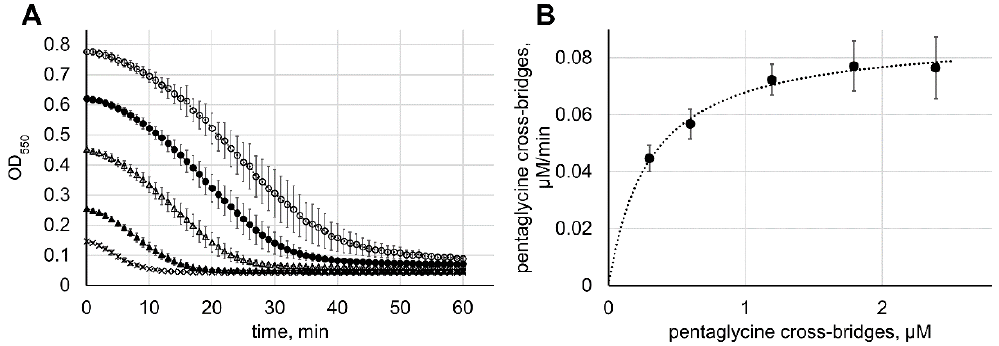
Figure 4. Derivation of apparent catalytic parameters of lysostaphin on pentaglycine incorporated into the cell wall. ( A ) Staphylococcal cells at different initial densities (open circles—8.0 McFarland, filled circles—6.0 McFarland, open triangles—4.0 McFarland, filled triangles—2.0 McFarland, crosses—1.0 McFarland) were mixed with 30 nM lysostaphin, incubated at 37 °C with constant shaking, and the optical density was measured at 1 min intervals at λ = 550 nm. The average results from three independent experiments are shown; error bars represent standard deviation. ( B ) The rate of decrease of staphylococcal cell suspension turbidity at different starting cell densities was calculated by approximating the curves (panel ( A )) with five parameters logistic equation and taking the first derivative at the inflection point. These rates were converted to the rates of pentaglycine cross-bridge hydrolysis, plotted against initial pentaglycine cross-bridge concentration, and fitted with the Michaelis–Menten equation (dotted line). The average pentaglycine cross-bridge hydrolysis rates from three independent experiments are shown (filled circles); error bars represent standard deviation.